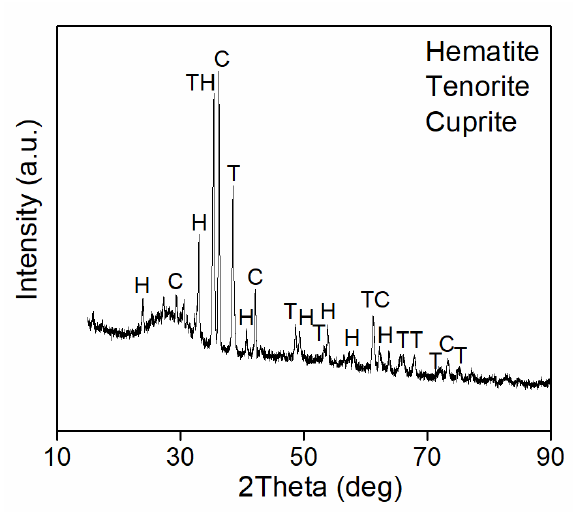
Figure A11. XRD result for lead white. Hydrocerussite (Y) was identified.